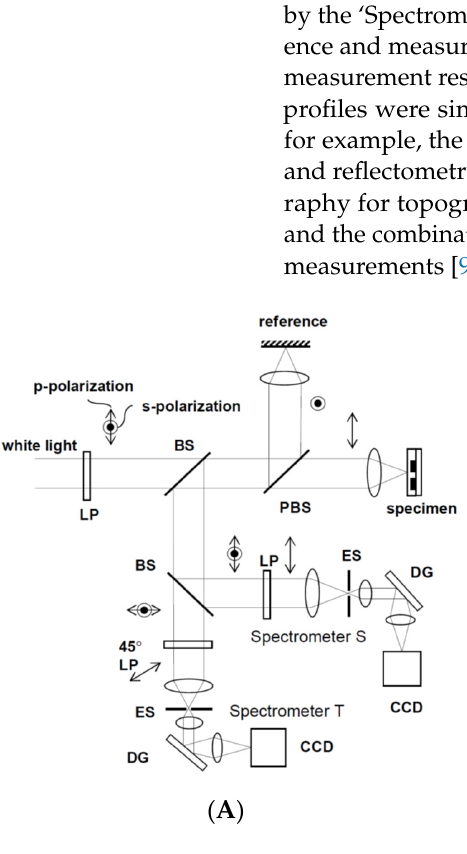
Figure 11. Hybrid film measurement system with ( A ) spectrally-resolved interferometry and reflec- tometry (reprinted/adapted with permission from [91] © The Optical Society(and ( B ) spectrally re- solved interferometry and spectroscopic ellipsometry (reprinted/adapted with permission from [95] © The Optical Society); LP, linear polarizer; BS, beam splitter; PBS, polarizing beam splitter; ES, entrance slit; DG, dispersive grating; CCD, charge coupled device; P, polarizer; C R , rotating compen- sator; BS, beam splitter; BSH, beam shutter; A, analyzer; IL imaging lens; IS, imaging spectrometer; M R and M M , a reference and measurement mirrors; PZT, piezoelectric transducer.